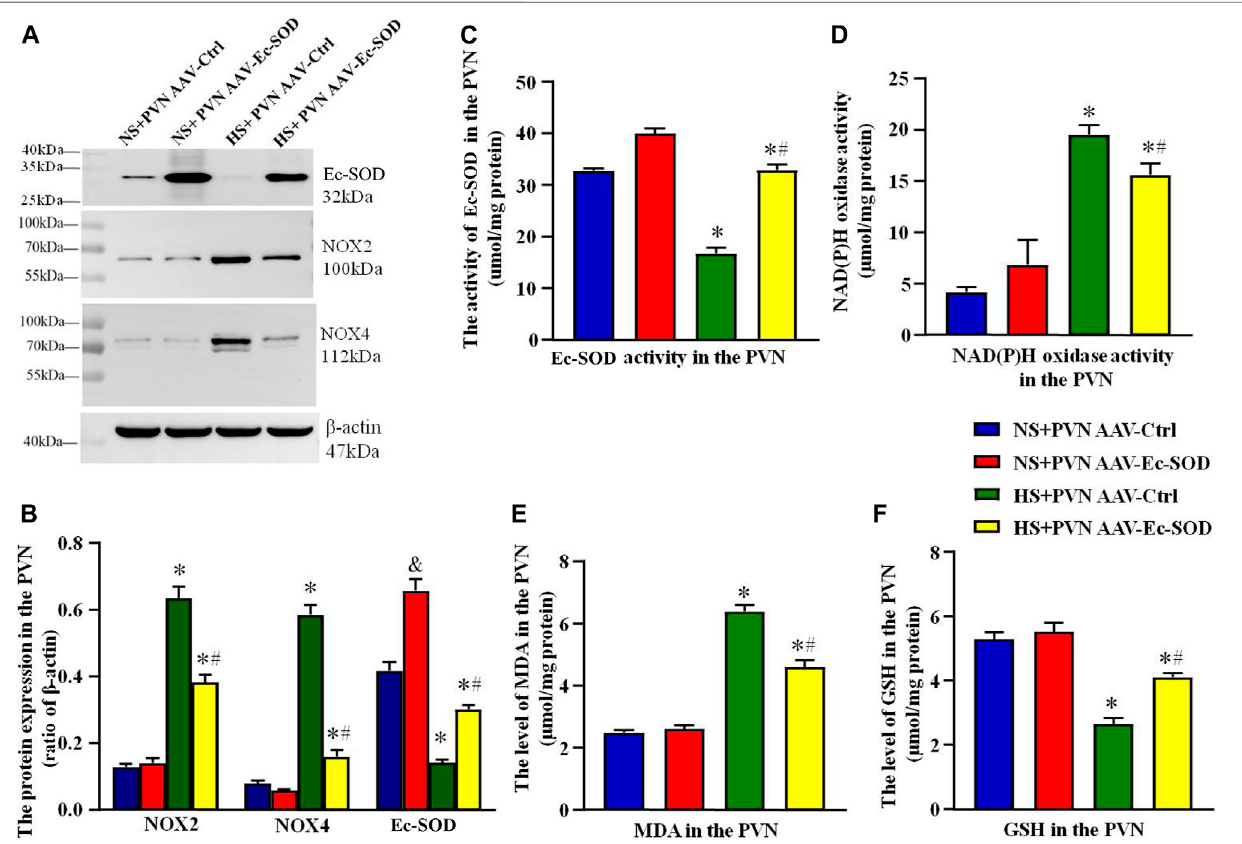
FIGURE 2 | Effect of AAV-Ec-SOD on oxidative stress – related indicators in the PVN. (A) Representative immunoblot and (B) densitometric analysis of PVN expression levels ofEc-SOD, NOX2, and NOX4 in different groups. (C) Column diagrams for Ec-SOD activity, (D) NAD(P)H oxidase activity, (E) MAD level, (F) GSH level inthePVNofdifferentgroups.Valuesareexpressedasmean ± SEM(n (cid:2) 4 – 6). & p < 0.05AAV-Ctrl vs. AAV-Ec-SOD;* p < 0.05NS+PVNAAV-Ctrl vs. HS+PVNAAV-Ec- SOD; # p < 0.05 HS + PVN AAV-Ctrl vs. HS + PVN